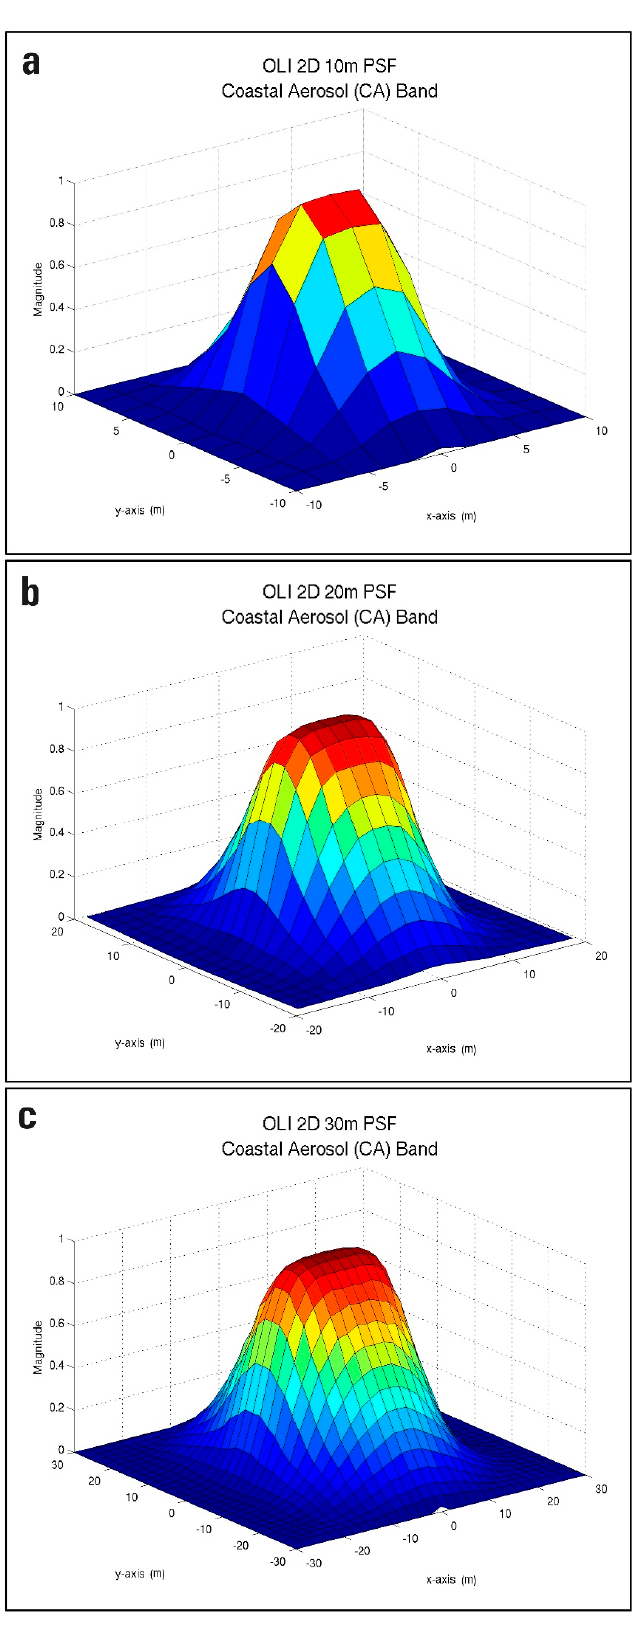
Figure 2. Subsampled Landsat OLI point spread function (PSF) for the coastal aerosol band at 10-m ( a ), 20-m, ( b ), and 30-m ( c )